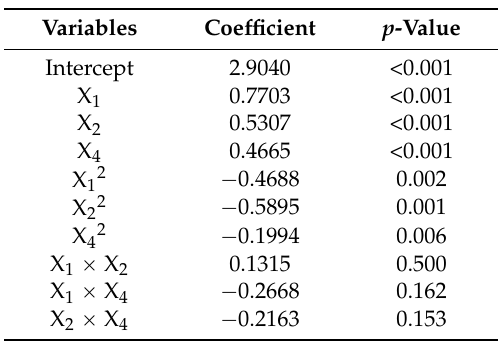
Table 4. Regression results of the Box–Behnken